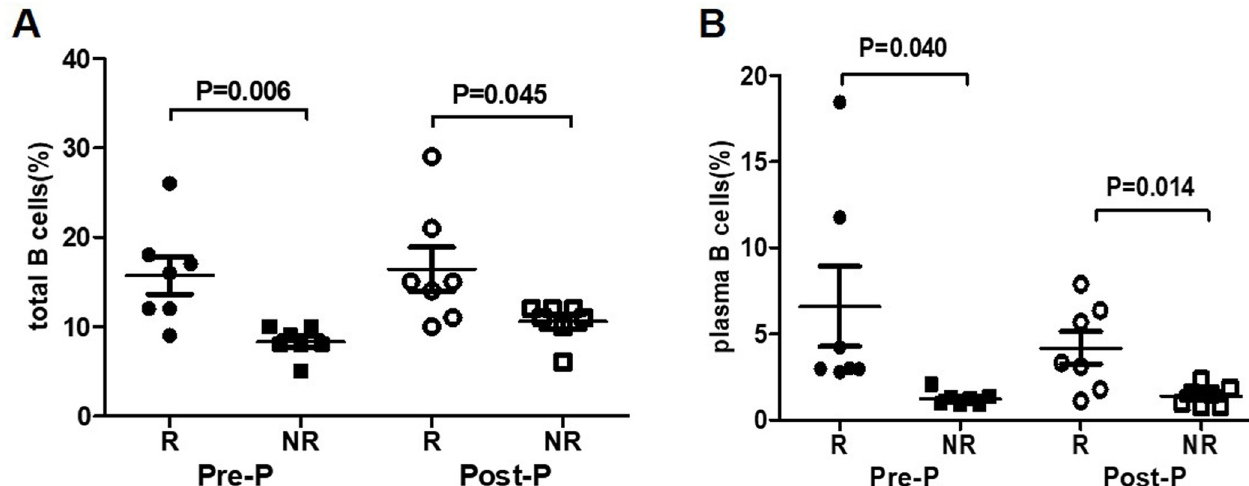
Fig 5. Comparison of total B and plasma B cells between R group and NR group during PEG-IFN treatment (A) Total B cells in age-, sex-, and HBsAg level at baseline -matched patients: comparison between IHCs who achieved seroconversion at 24 weeks of treatment (n = 7) and the patients who failed at 24 weeks of treatment (n = 7). (B) Plasma B cells in age-, sex-, and HBsAg level at baseline-matched patients: Comparison between IHCs who achieved HBsAg seroconversion at 24 weeks of treatment (n = 7) and the patients who failed at 24 weeks of treatment (n = 7).